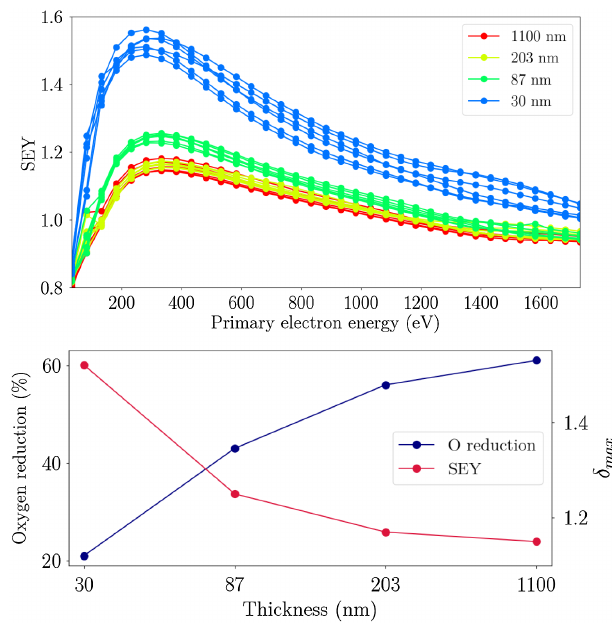
FIG. 12. SEY as a function of the photoelectrons energy (top) and oxygen reduction and maximum SEY as a function of the coating thickness (bottom) for all the samples under study after the fourth activation cycle of 4 hours up to a temperature of 250 °C.